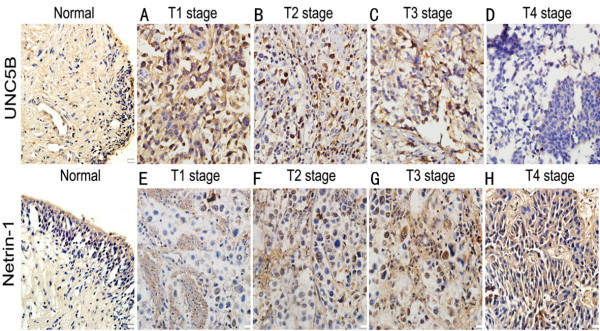
Representative images from immunohistochemical staining in different histological stages UNC5B was localized at cytoplasm and netrin-1 was mainly in cell nucleus and partly in cell cytoplasm of tumor tissues with granular brown staining. Almost all T1 tumor tissues showed strong UNC5B staining intensity. UNC5B expression in stage T4 was significantly less than in stage T1–T3 specimens (Figure 3A, B, C & D) (P = 0.021). While netrin-1 showed strong expression in stage T4 than other stages (T3, T2 & T1) and was associated significantly with pT stage (Figure 3E, F, G & H) (P = 0.013). Representative tissue sections with different immunointensity of UNC5B protein in A T1, B T2, C T3 & D T4. E Low level of netrin-1 expression in T1, H High level of netrin-1 expression in T4, F & G represent T2 &T3. Magnification × 400. *P < 0.05 compared with stage normal bladder tissues (paired t-test).